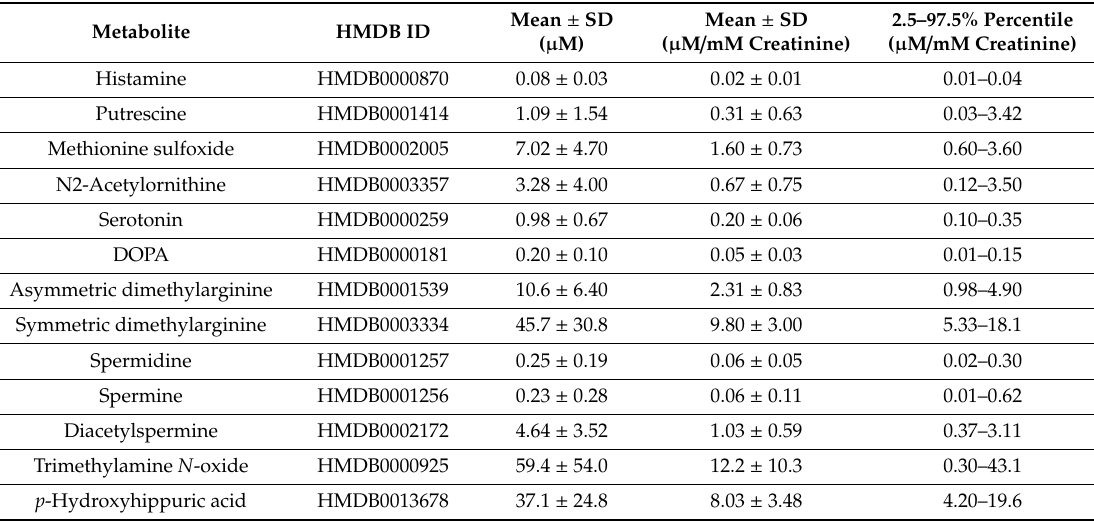
Table 2. Metabolites not previously reported in